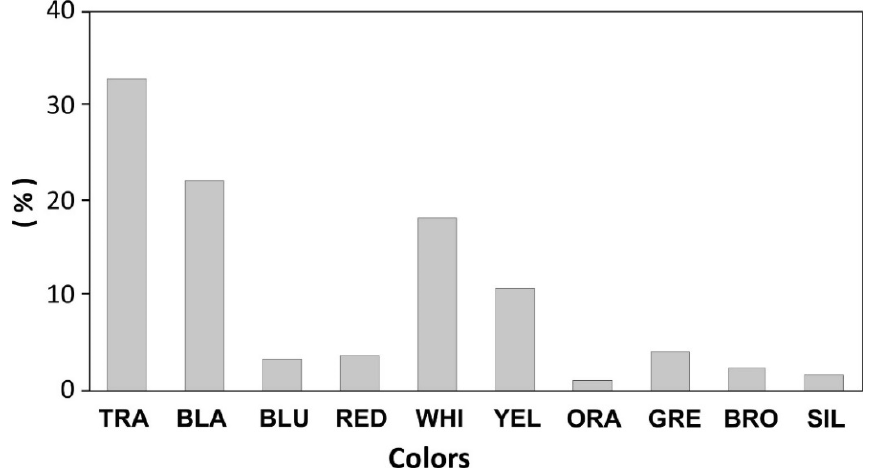
Figure 8. The (%) proportion of the different colors of the overall microplastic fragments recovered from the total number of samples in the four sampling areas (Latsi, Amathounta, Meneou and Protaras) during the years 2017–2019. (TRA = transparent, BLA = black, BLU = blue, RED = red, WHI = white, YEL = yellow, ORA = orange, GRE = green, BRO = brown, SIL = silver).